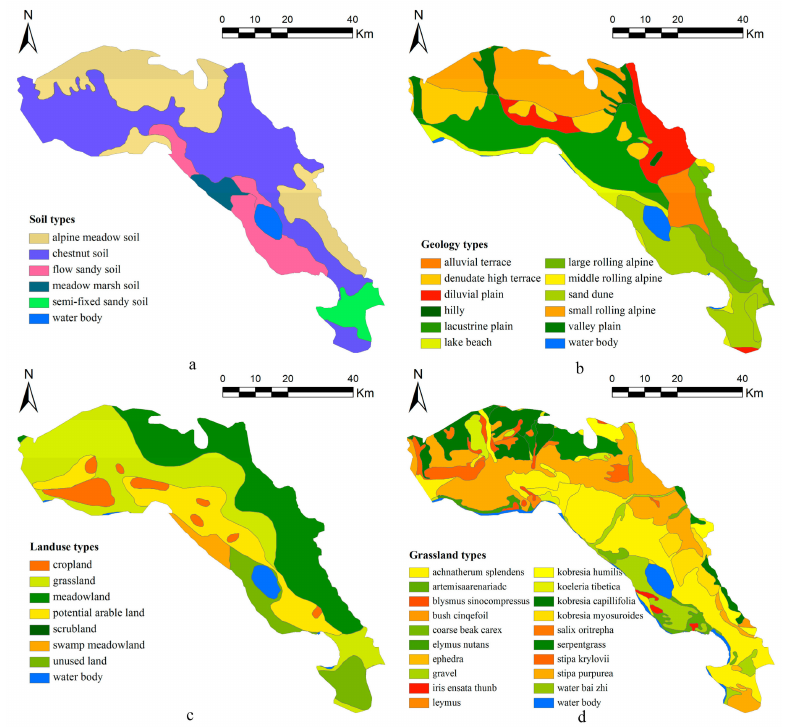
Figure 2. Characteristics of the study area: ( a ) soil types, from the 1: 1,000,000 soil map of the China Soil Investigation Office; ( b ) geology types, from the 1:500,000 geologic map of the Bureau of Geological Exploration and Development of Qinghai Province; ( c ) land use types; and ( d ) grassland